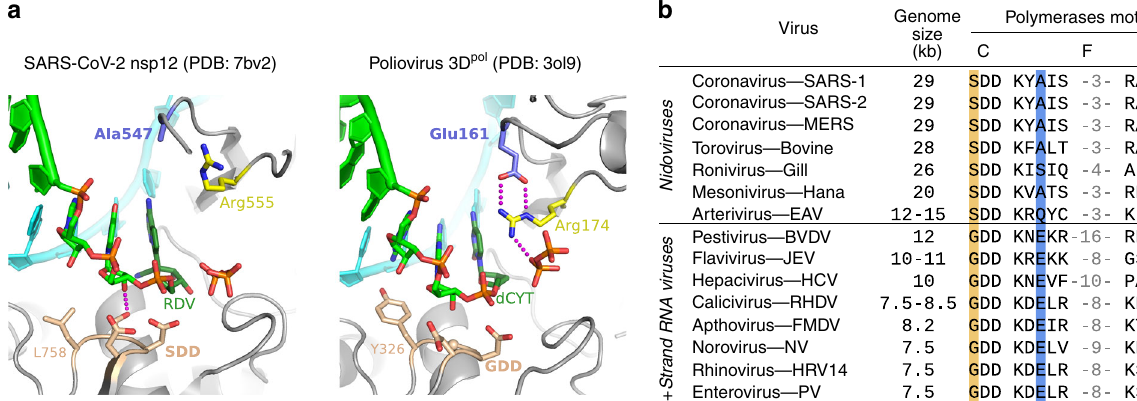
Fig. 6 Comparison of viral polymerase active site structures and sequences. a Analogous post-catalysis, pre-translocation structures of CoV nsp12 and poliovirus 3D pol after incorporation of remdesivir (RDV) and deoxycytosine (dCYT), respectively. The CoV polymerases have replaced a motif F glutamate residue (3D pol Glu161) with an alanine (nsp12 Ala547), removing a highly conserved interaction that positions the motif F arginine for interactions with the NTP and pyrophosphate. b Alignment of representative viral RdRp sequences showing the large genome nidoviruses have a SDD instead of GDD sequence in the palm domain motif C (tan) and alanine, serine or glutamine in place of the aforementioned glutamate (blue) found in other positive strand RNA viruses. The NTP-interacting arginine (yellow) is conserved, but the overall length of the motif F loop is shorter in the nidoviruses (numbers re fl ect omitted